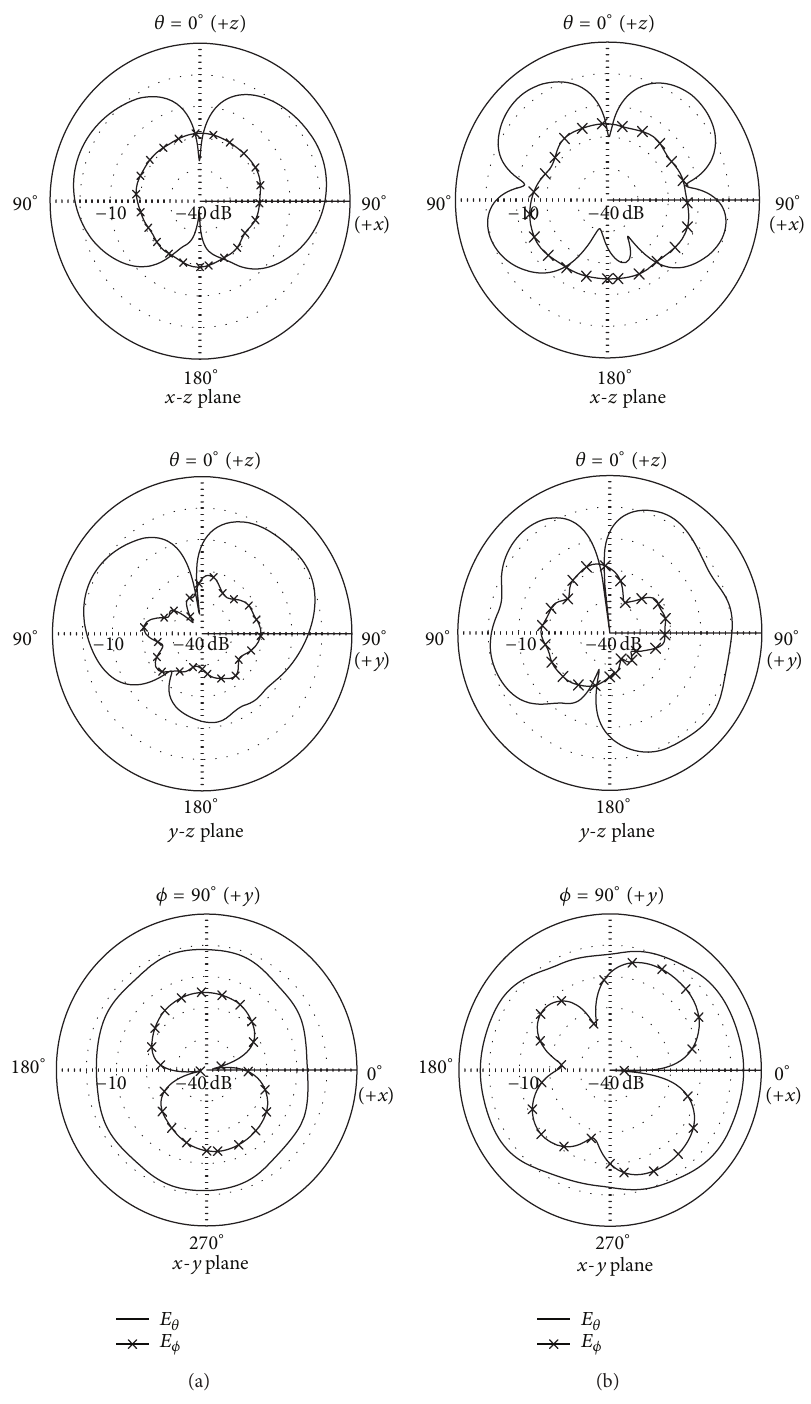
Figure 7: Simulated radiation patterns of proposed FC-PIFA obtained at (a) 2.45 and (b) 5.5 GHz.